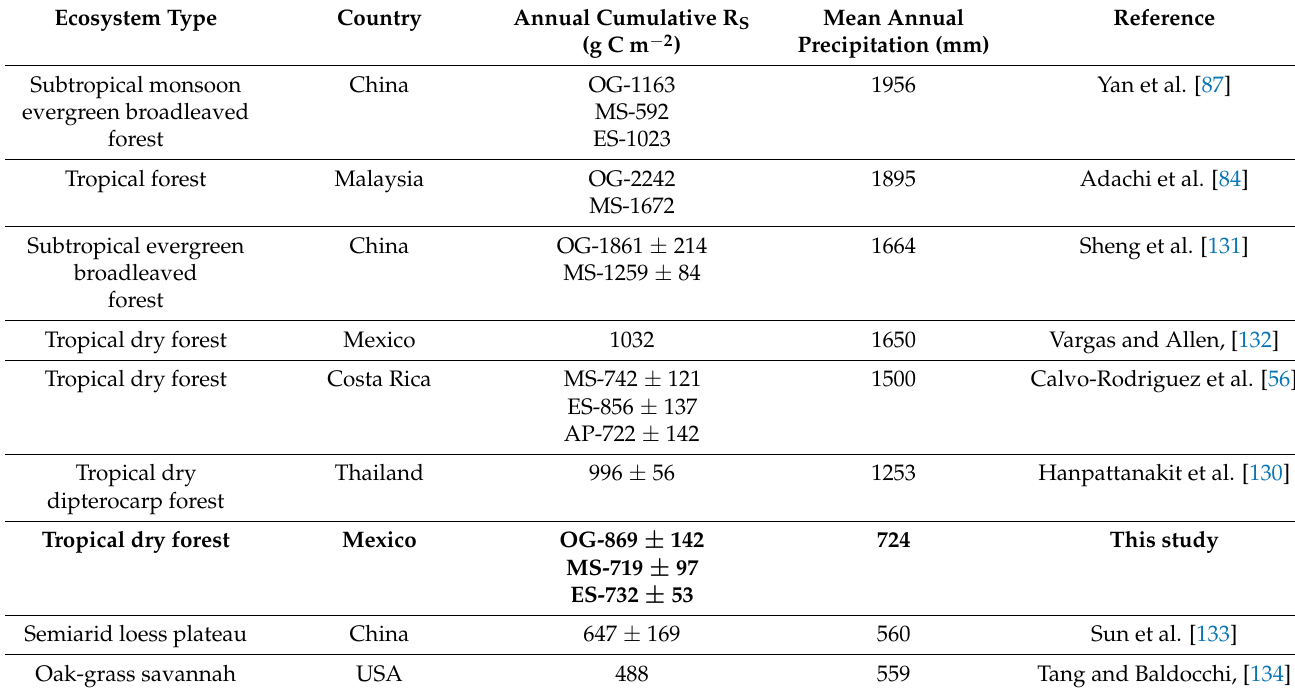
Table 7. Annual cumulative R S estimates along a precipitation gradient from tropical and subtropical ecosystems. Study sites are displayed according to the mean annual precipitation. Mean ± standard deviation is expressed in multiyear